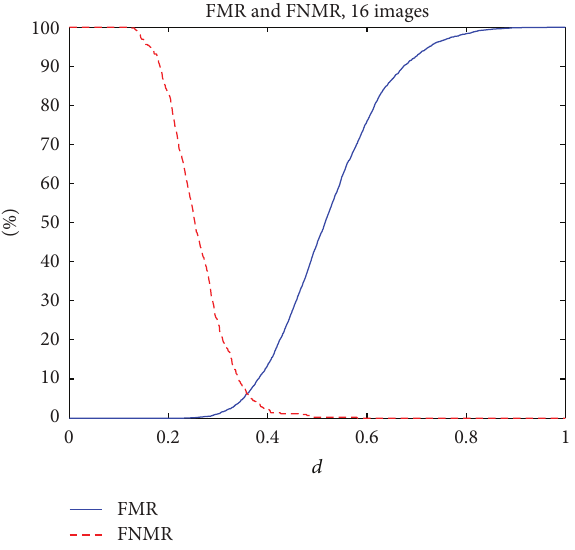
Figure 7: Functions FMR and FNMR versus distance 𝑑 .